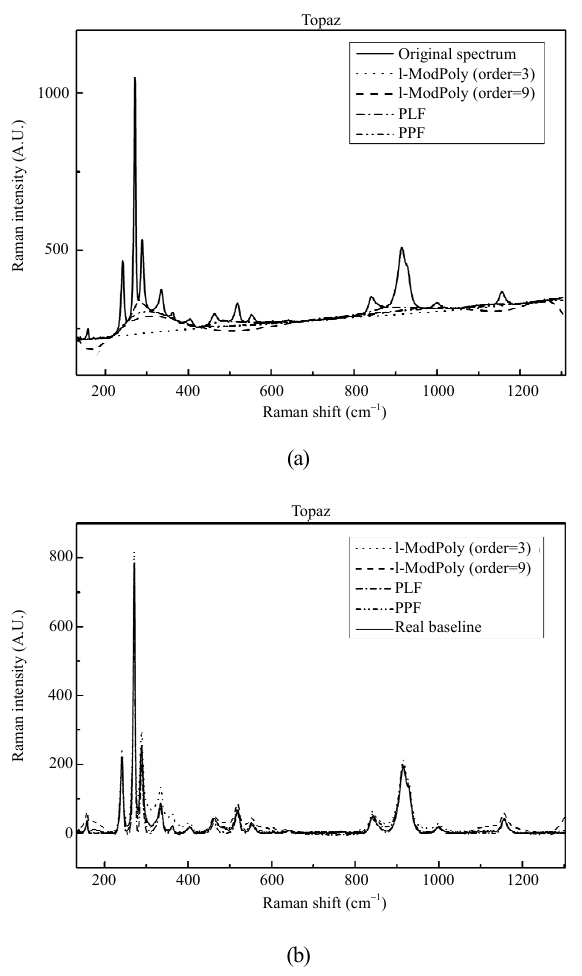
Fig. 9 Baseline correction for topaz: (a) the original spectra and the background and (b) final pure Raman spectra fitted by the three different methods in the appropriate